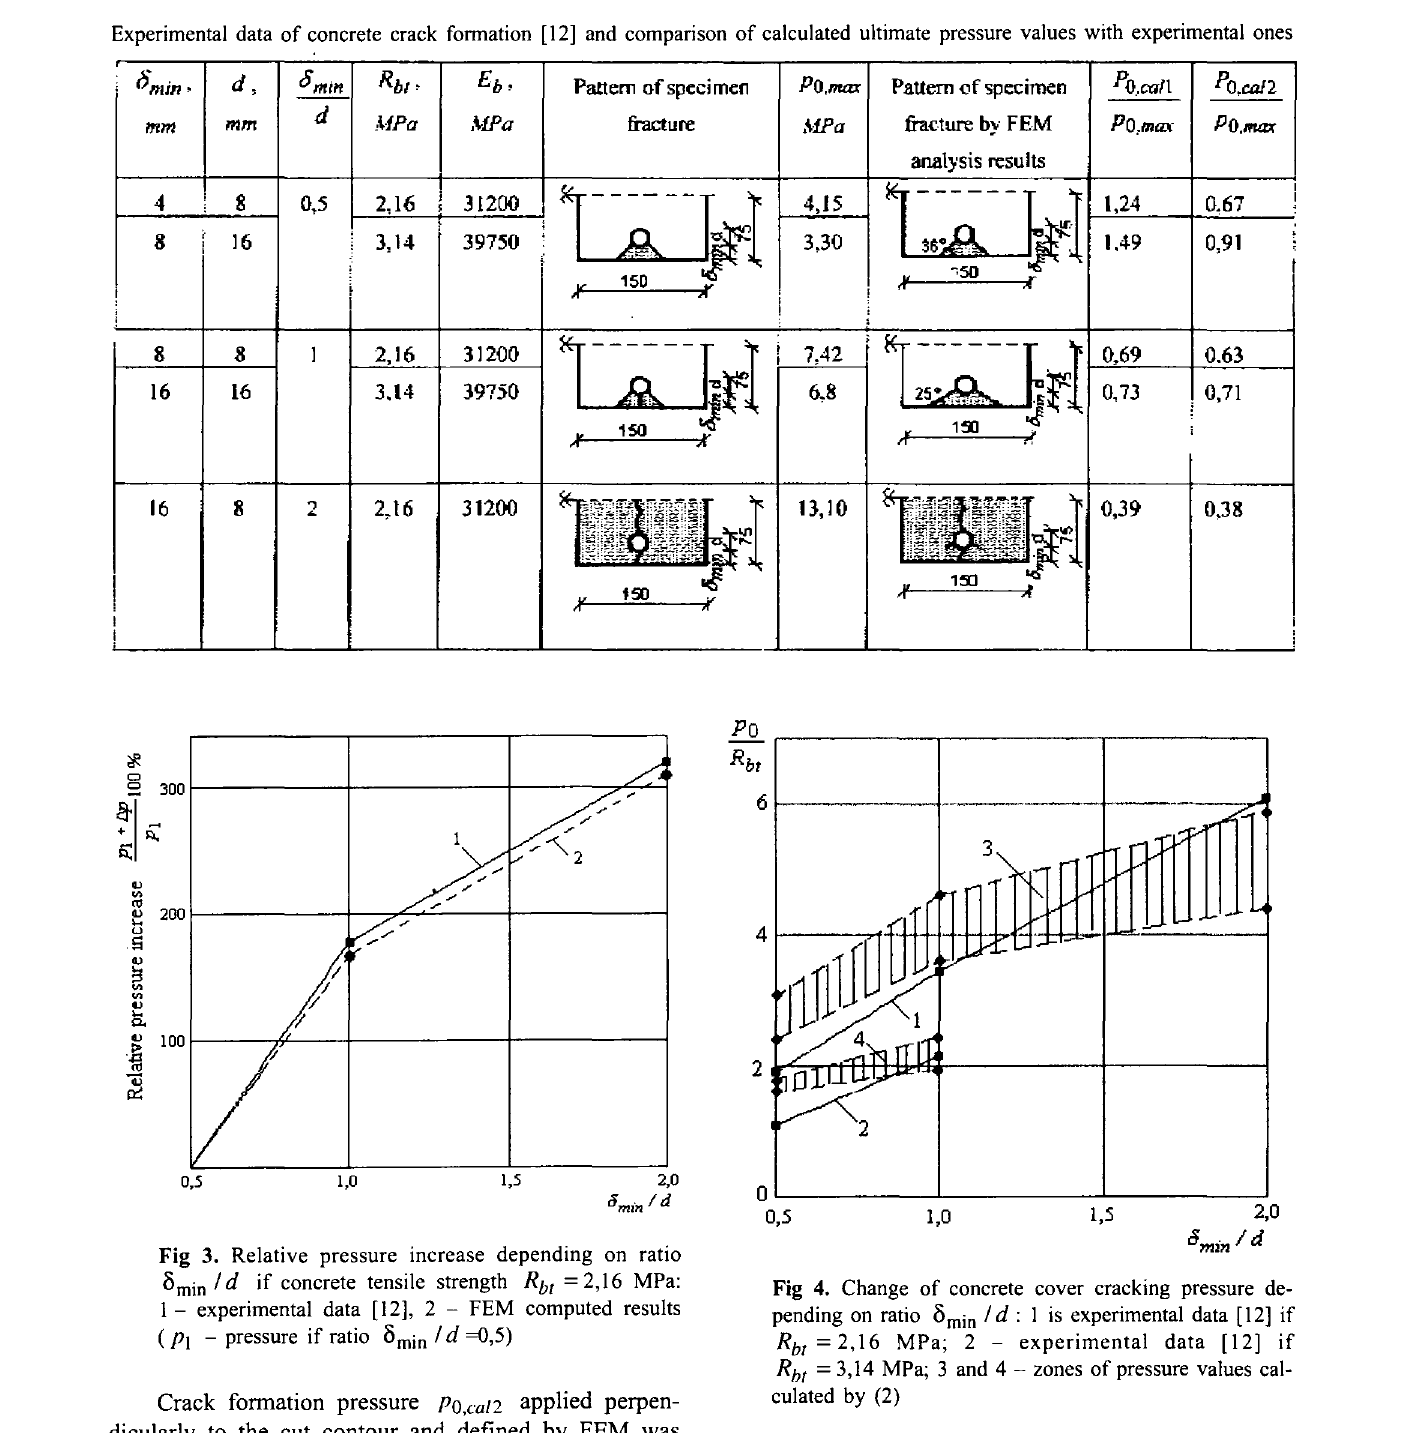
Fig 4. Change of concrete cover cracking pressure